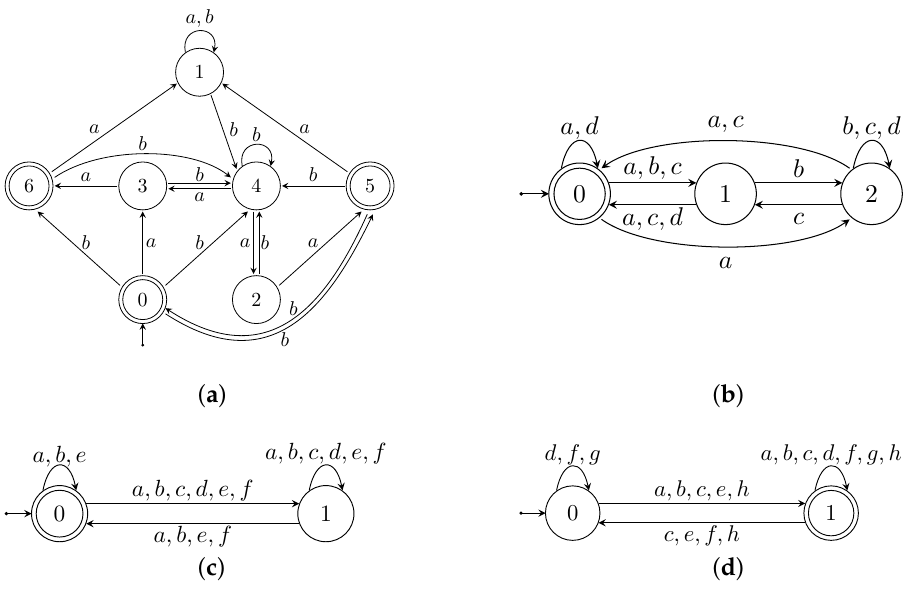
Figure 2. Example solutions found by the ASP solver for problems a2words33, a4words28, a6words31, and a8words37. ( a ) Problem a2words33; ( b ) Problem a4words28; ( c ) Problem